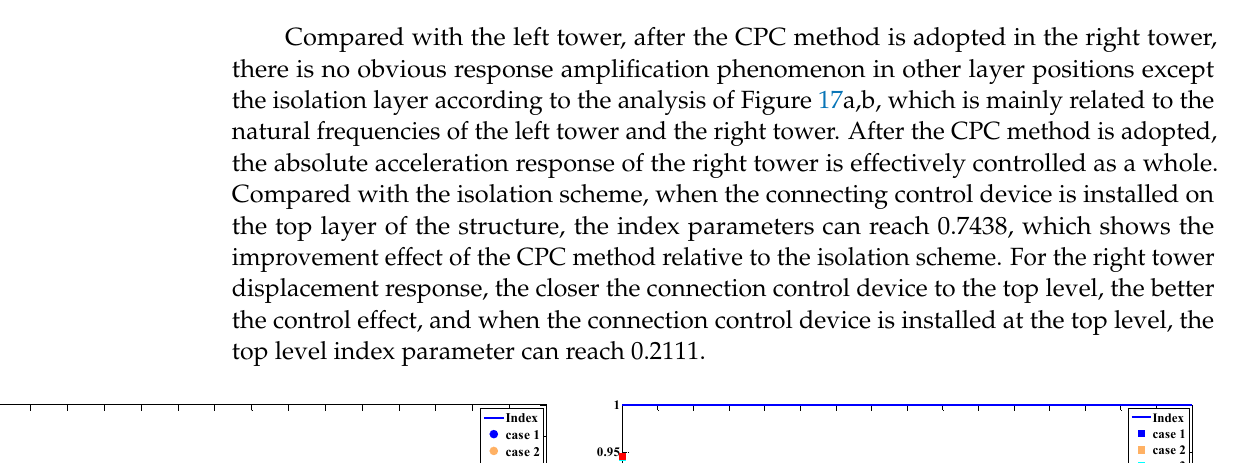
Figure 16. ( a ) Control effect of displacement response of left tower; ( b ) control effect of absolute acceleration response of left tower.